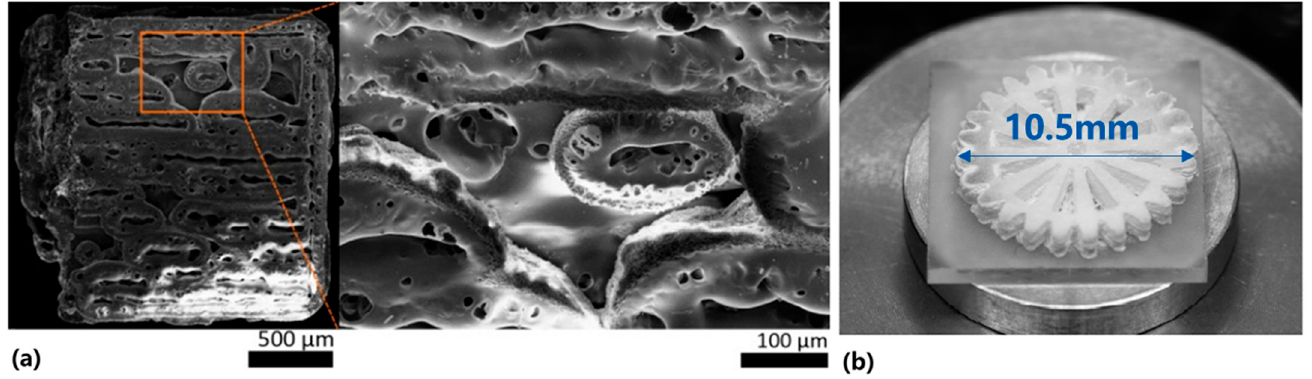
Figure 4. ( a ) SEM image (top view) of a fabricated cubic sample, exhibiting molten tracks and gas inclusions due to the high viscosity of glass. ( b ) Fabricated gear wheel with dimensions of 10.5 mm in diameter and 1.5 mm height [33].